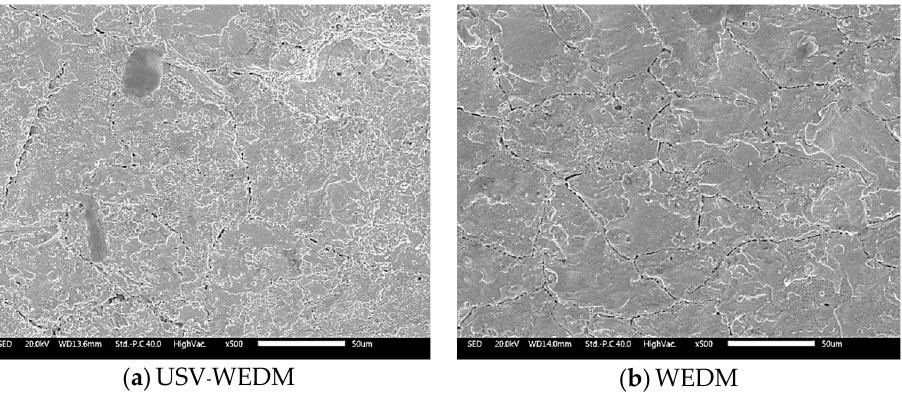
Figure 9 . SEM images of surface of workpiece ( a ) with and ( b ) without Ultrasonic Vibration - Assisted WEDM .